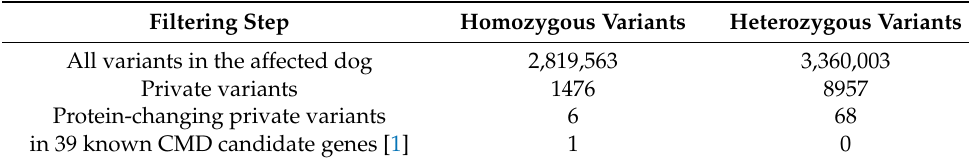
Table 1. Results of variant filtering in affected dog against 795 control genomes.